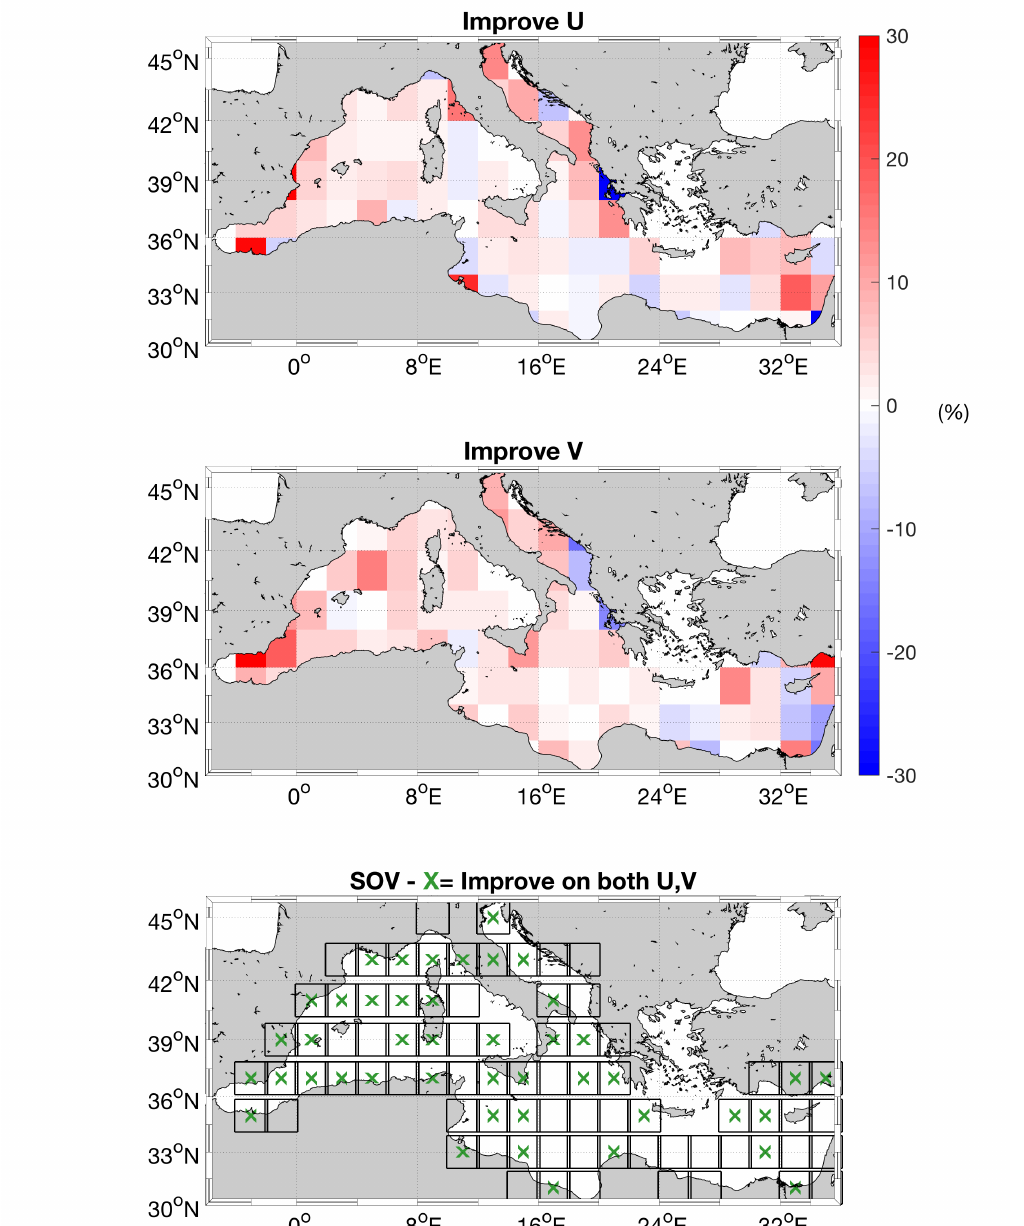
Figure 10. Spatial variability of the percentage of improvement of the Optimal reconstruction method for the zonal (U) and meridional component (V) of the surface motion, respectively shown in the top and middle panel of the figure. The percentage of improvement, binned in 2 ◦ × 2 ◦ boxes has been computed in the sites of validation (SOV) given by the black squares in the bottom panel. The crosses indicate the SOV where both the zonal and meridional components of the motion are